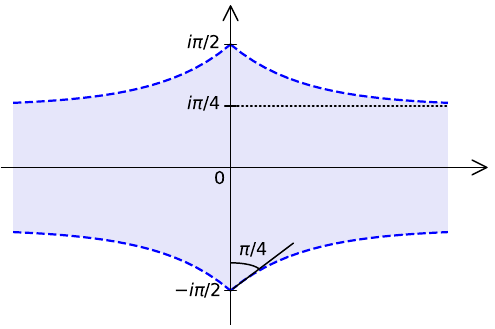
Figure 1 . The painted over domain of complex plane of θ is Θ . It does not include the